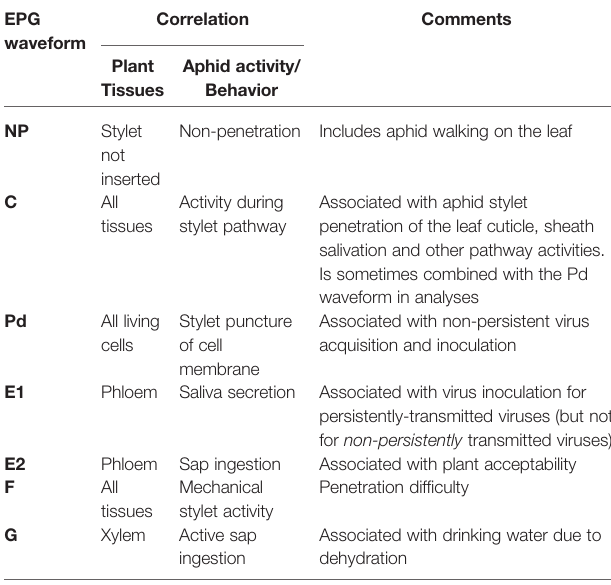
TABLE 1 | Summary of electrical penetration graph (EPG) waveforms used in data